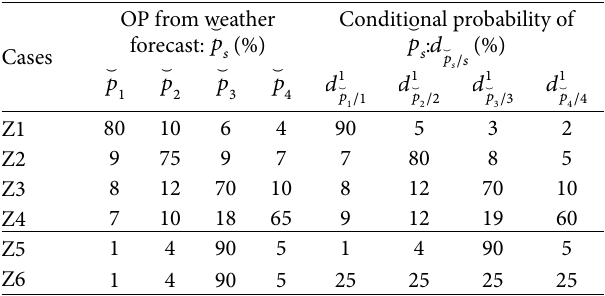
Table 6: Different occurring probability (OP) and conditional